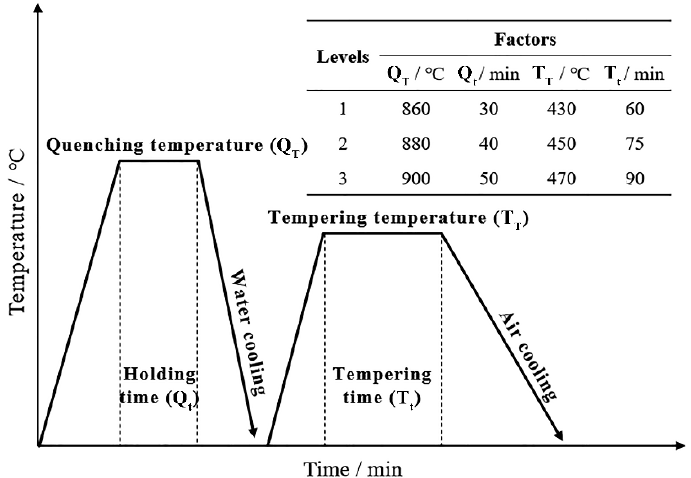
Figure 1. The quenching and tempering heat treatment process of Φ 13 mm 38Si7 spring steel, and the four-factor three-level method.